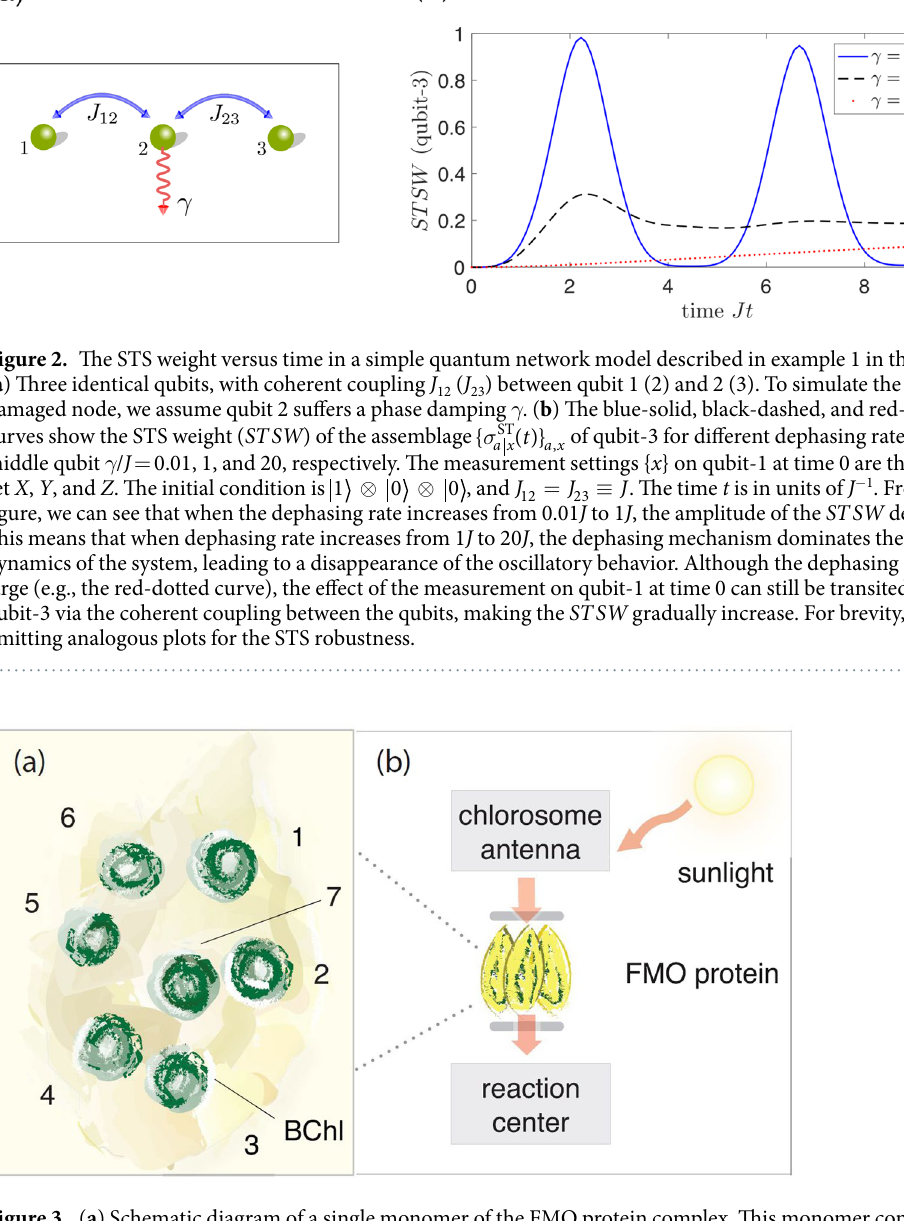
the STS weight oscillates with time t , revealing the coherent interaction between qubits 1 and 3 via the middle qubit. If γ is large (i.e. the middle node is damaged), one sees the growth of the STS weight at a later time. One can imagine that if the dephasing is very strong, it can inhibit the appearance of the STS weight. However, several caveats arise in that the apparent correlations may be transmitted via other means than the network itself (via some environment or eavesdropper). A possible opening for future research in this area is to consider a multi-partite extension, and whether it can be used as a measure of quantum communities in networks 65 . Example 2: The spatio-temporal steering robustness in the Fenna-Matthews-Olson complex. Much attention has been devoted to the possible functional role of quantum coherence 66, 67 in photosynthesis bacteria, since the observation of possible quantum coherent motion of an excitation within the FMO complex – a photosynthetic